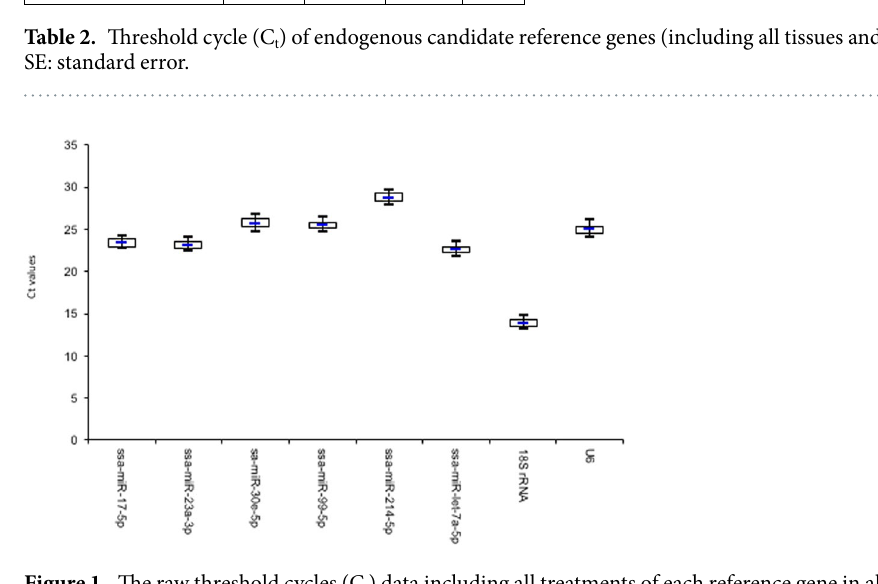
Figure 1. The raw threshold cycles (C t ) data including all treatments of each reference gene in all the samples are represented in a box-and-whisker figure. Boxes represent the 25 and 75 percentiles with medians indicated. The whisker represent the highest and lowest values.